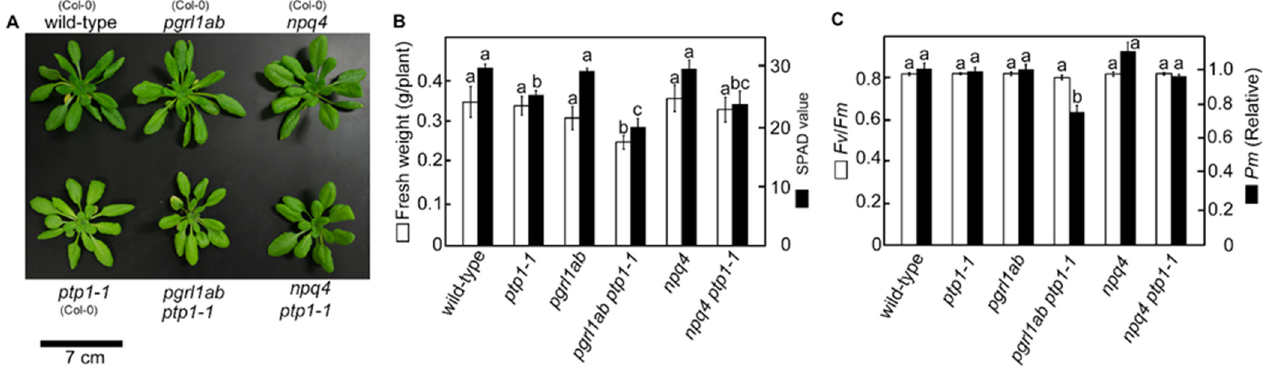
Figure 2. The phenotypic recovery in complementation lines. ( A – C ) and ( D – F ) were the data of plants grown under con- stant (250 μ mol-photons m − 2 s − 1 ) and natural light conditions, respectively. ( A , D ) are pictures of representative plants grown for 22 days and 20 days, respectively. The parentheses indicate the background genotypes of each mutant. The scale bars in ( A , D ) are 5 and 8 cm, respectively. ( B , E ) show fresh weight (white bars) and SPAD values (black bars). Data are means ± sd. (( B ), n = 6; ( E ), n = 4–5) ( C , F ) show the maximum quantum yield in PSII ( Fv/Fm ; white bars) and the maximum amount of photo-oxidizable PSI ( Pm ; black bars). Data are means ± sd. (C, n = 5–6; F, n = 4–5) Pm is a relative value with the value wild-type Col-0 being 1. In ( B , C , E , F ), the different alphabets indicate significant differences analyzed by Tukey’s HSD test. ( p < 0.05).